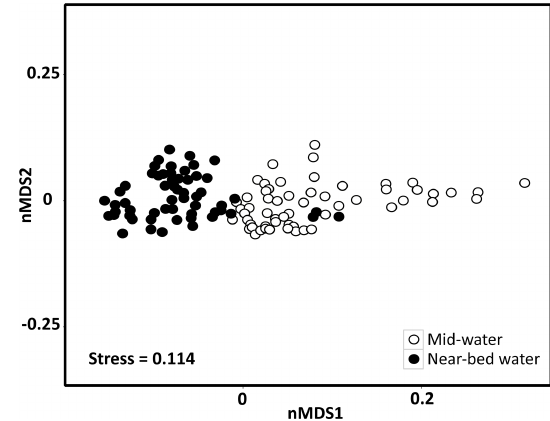
Figure 2. Seawater microbial community composition of mid-water and near-bed water samples visualized by a non-metric multidimen- sional scaling plot on weighted UniFrac distances. Each marker is one microbial community, with colours indicating the sample sub- type (i.e. mid-water or near-bed